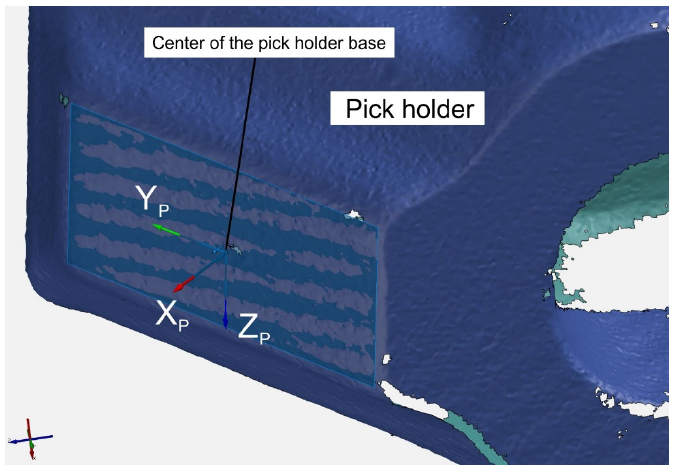
Figure 20. Design of the pick holder base plane and the X P Y P Z P coordinate system hooked in the middle of the pick holder base built-in GOM Inspect Professional (GOM GmbH, Braunschweig, Germany).